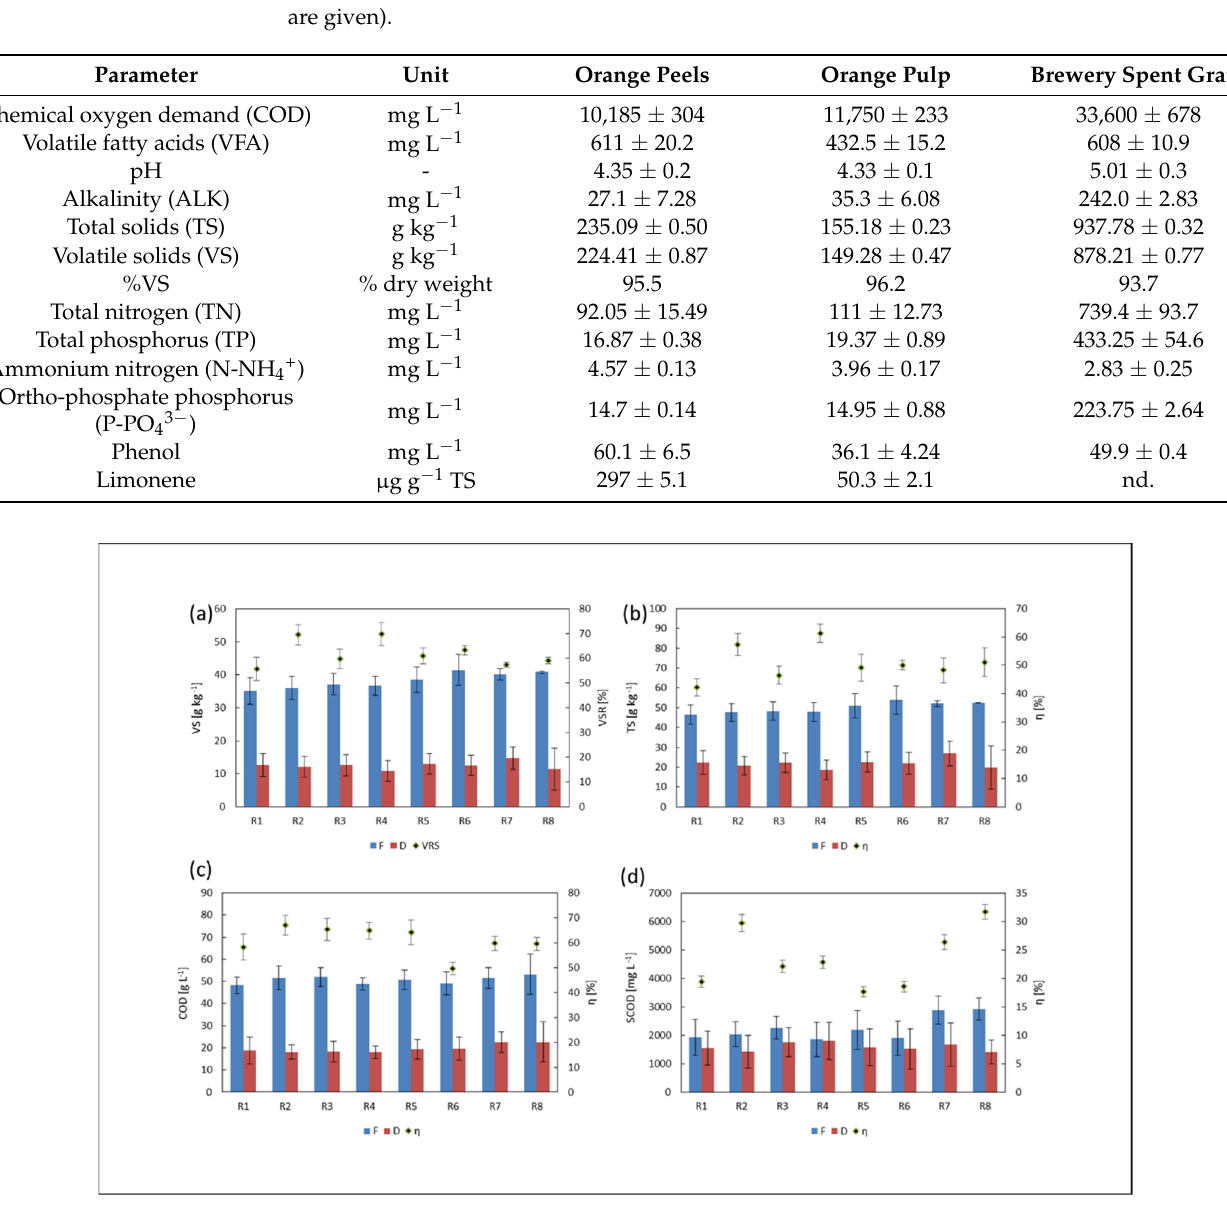
Figure 1. Content of VS ( a ), TS ( b ), COD ( c ) and SCOD ( d ) in feedstock (F) and digestate (D), as well as related removal efficiencies (average values and standard deviations are given). as related removal efficiencies (average values and standard deviations are